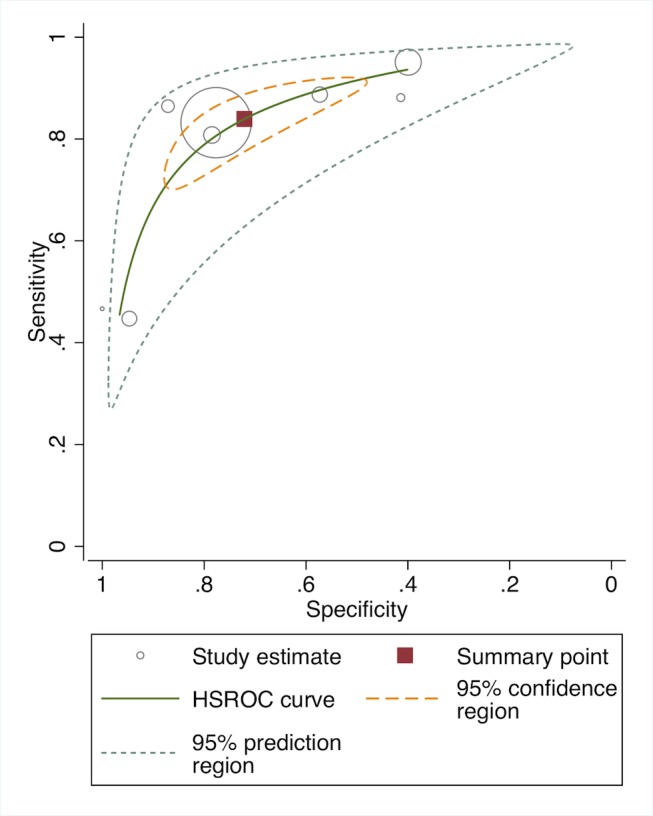
Receiver operating curve of studies of diagnostic accuracy of clinical sign algorithms versus physician-laboratory diagnosis of severe disease/pBI in young infants.